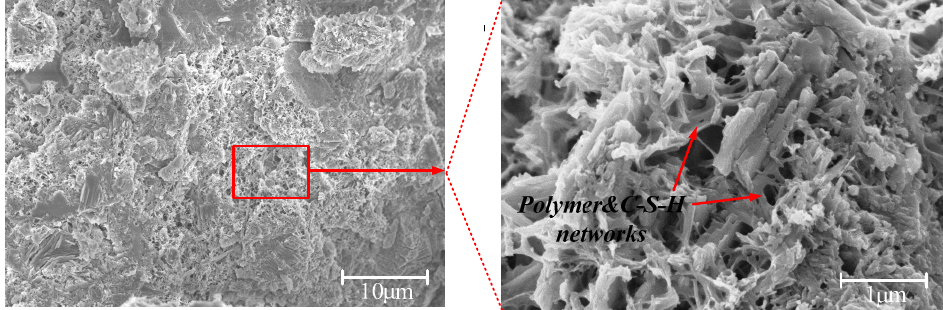
Figure 11. Polymer film stretched in open space in 0.6% PVA modified mortar at 28 days.